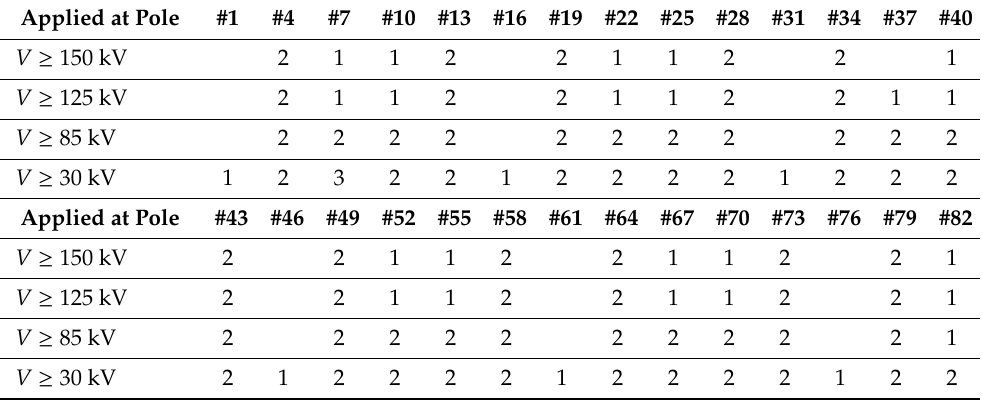
Table 3. Number of transformers with at least one phase reaching the critical overvoltage level. Case 1, wet arsenic-impregnated poles and grounded transformer poles.